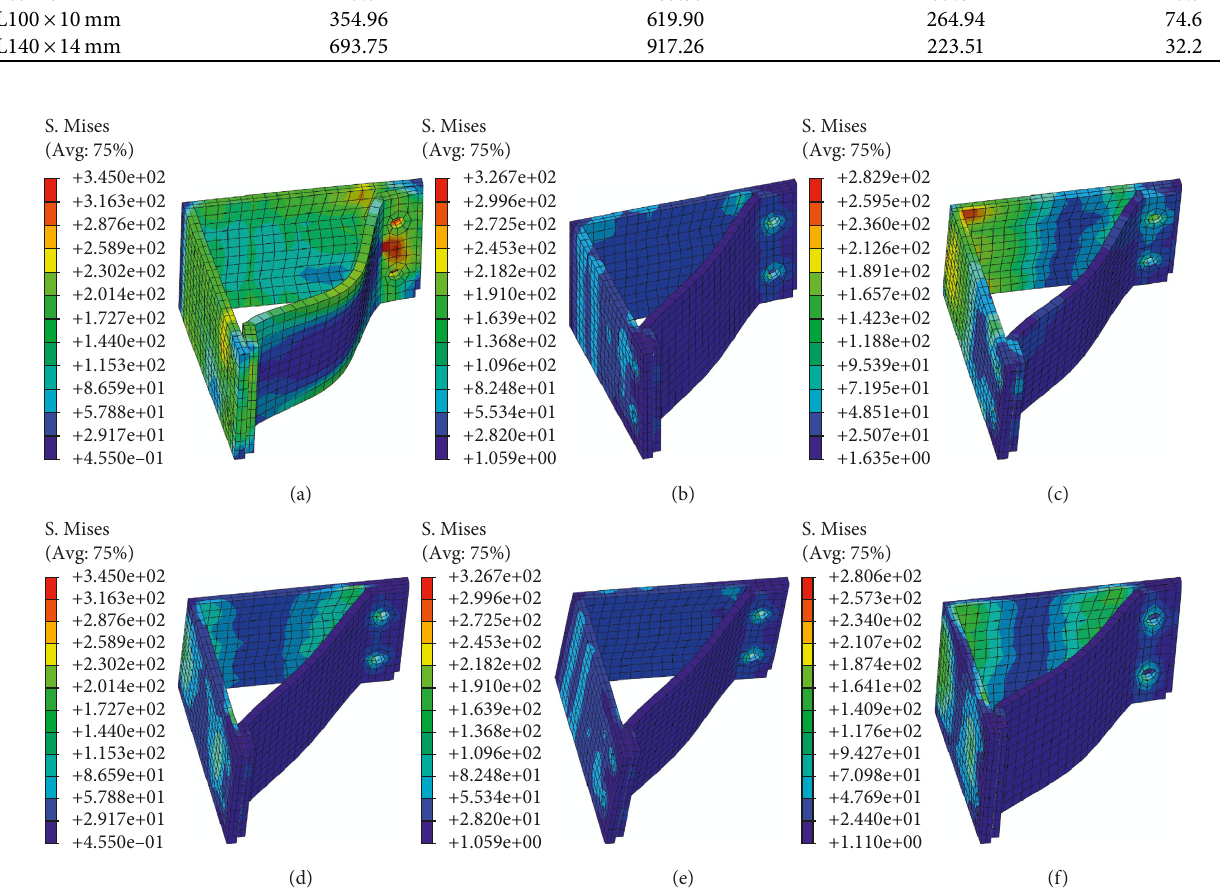
Figure 11: Fixture stress contours. (a) L100 × 10G57SR75-1150 end fixture. (b) L100 × 10G57SR75-575 end fixture. (c) L100 ×